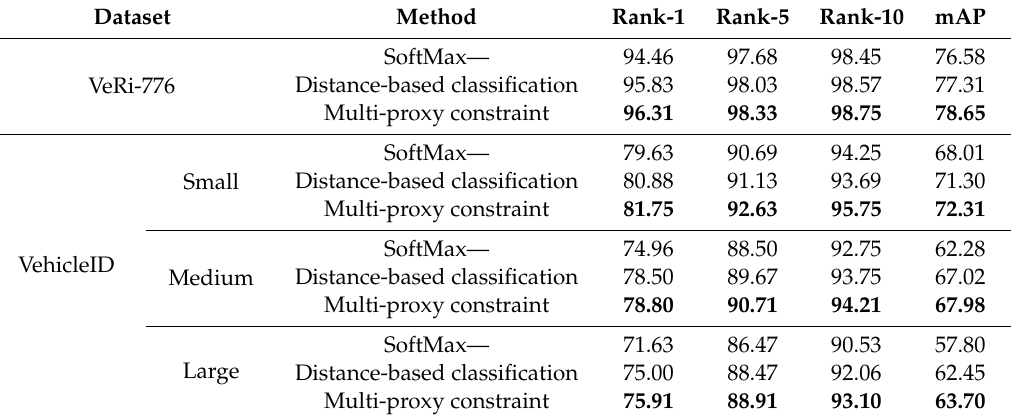
Table 3. Performance comparison on the VeRi-776 and VehicleID datasets.